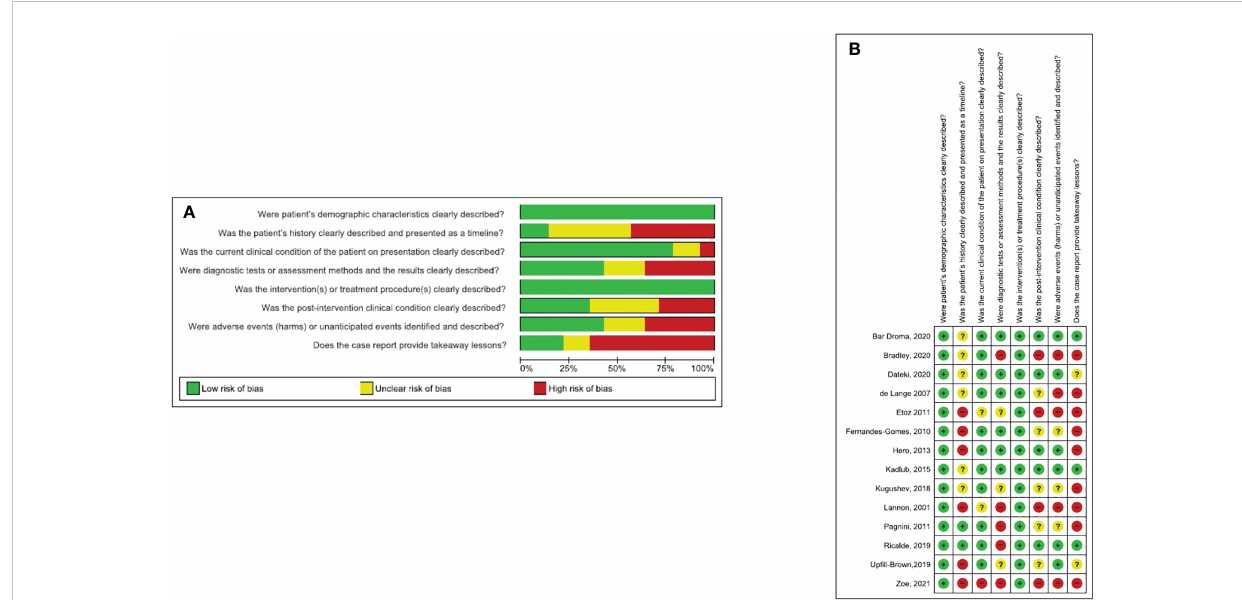
FIGURE 3 Risk of bias. (A) Risk of bias graph: review authors ’ judgments about each risk of bias items presented as percentages across all included studies. (B) Risk of bias summary: review authors ’ judgments about each risk of bias item for each included study.